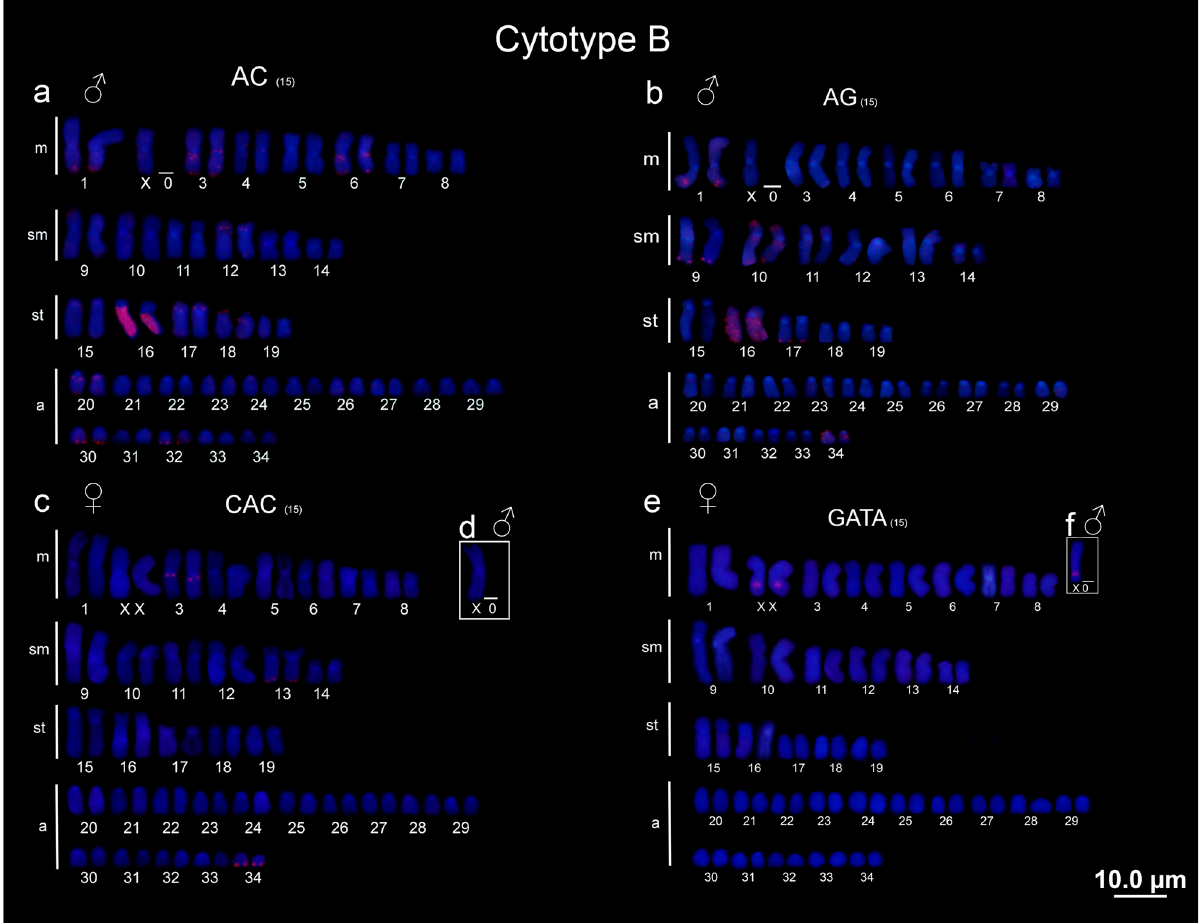
Fig 4. Microsatellites cytotype B. Microsatellite mapping (a) (AG) 15 , (b) (AC) 15 , (c) (CAC) 15 and (d) (GATA) 4 in metaphases of cytotype B.